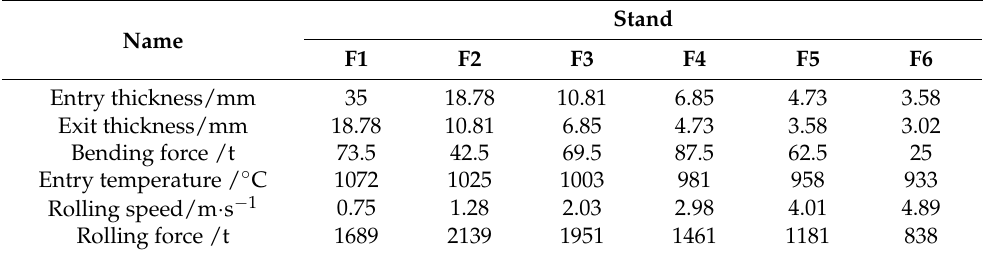
Table 1. Model simulation